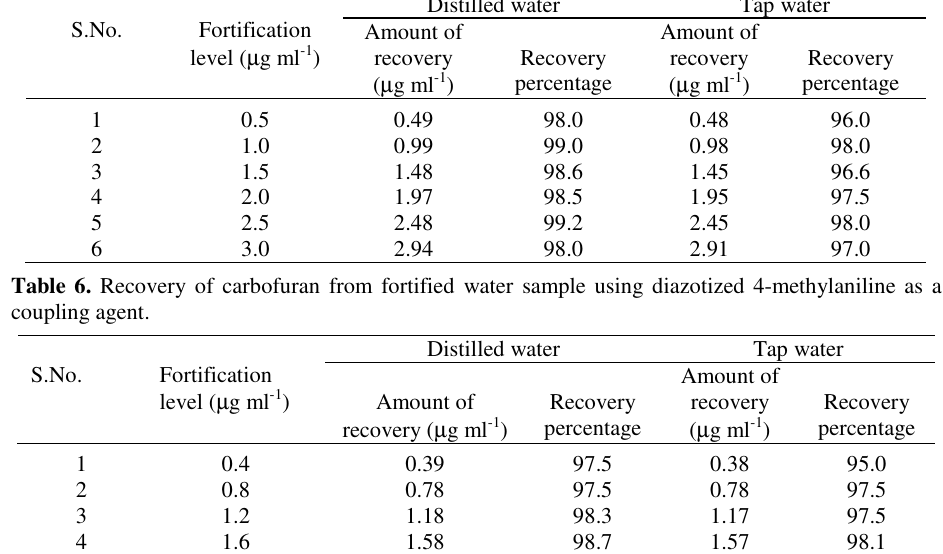
Table 5. Recovery of carbofuran from fortified water sample using diazotized 4-bromoaniline as a coupling agent. Distilled water Tap water S.No.